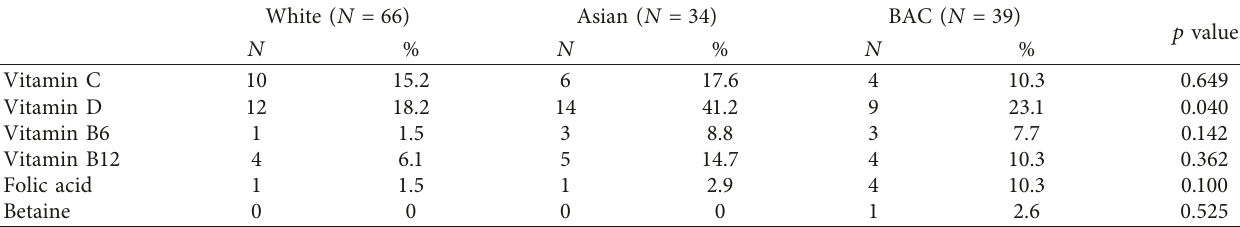
Table 3: Dietary habits including supplements between the three different ethnic